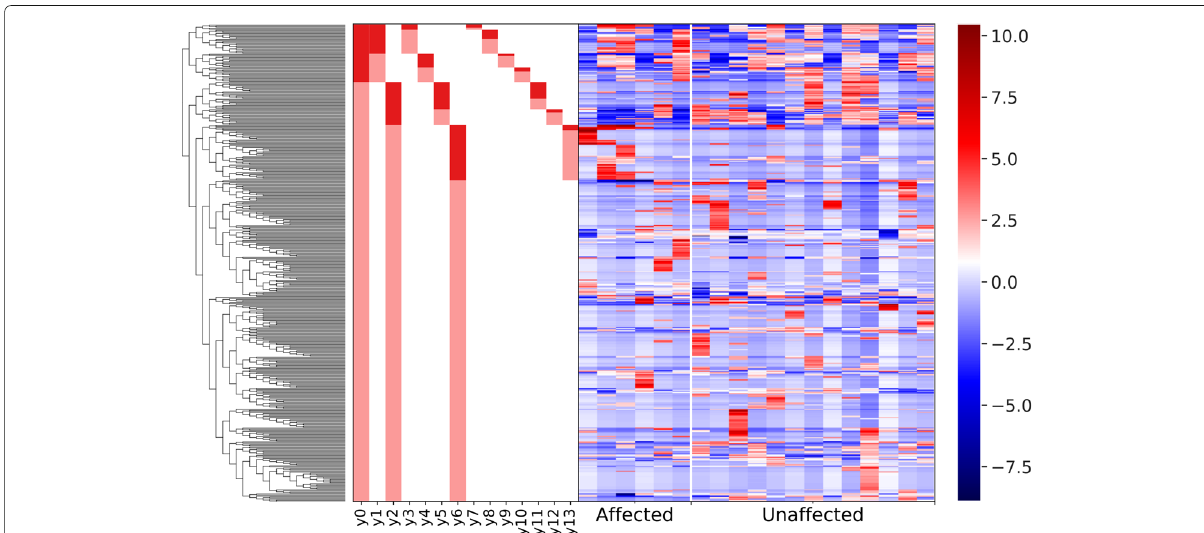
Fig. 4 A dendrogram heatmap showing log abundance of features in the tamarin faecal microbiome. The heatmap allows resolution of significant balances with a higher abundance of y2 denominator ASVs in unaffected tamarins while there was a higher abundance of y6 and y13 denominator ASVs in affected